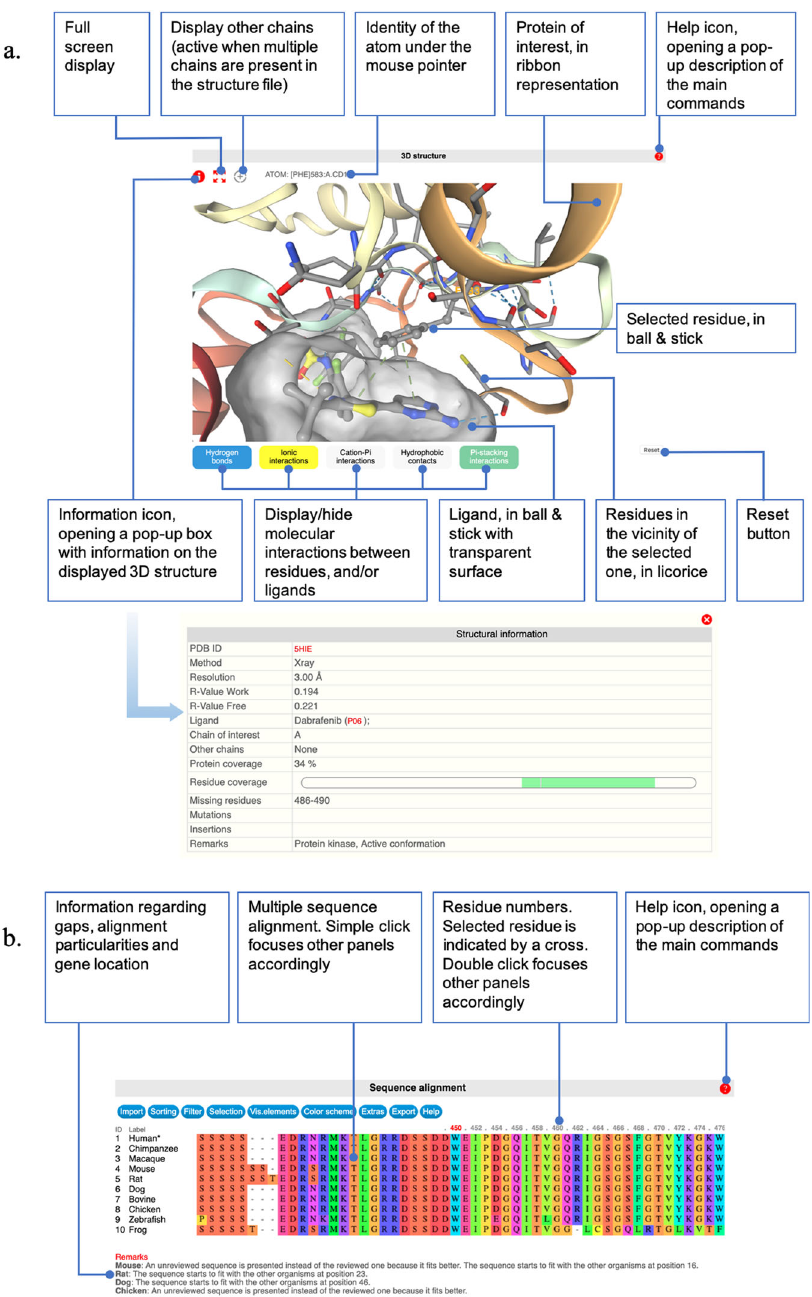
Fig. 5 3D-structure and sequence alignment panels. a 3D-structure panel. b Multiple sequence alignment selection of residues displayed in ball and stick or licorice. Importantly, it is possible to display several types of molecular interactions between the selected residue or ligand and its environment using the buttons available below the 3D viewer: hydrogen bonds, ionic interactions, cation – π interactions, hydro- phobic contacts, and π -stacking interactions. These interactions are displayed as dotted lines connecting the involved atoms. The color coding of the interaction types in the 3D display follows the one of the buttons that command their display or hiding. By default, only the main chain, corresponding to the protein of interest, is displayed in the 3D-structure panel. However, impacts of mutation are sometimes originating from their effects on the binding to other macromolecules. To analyze this, when several